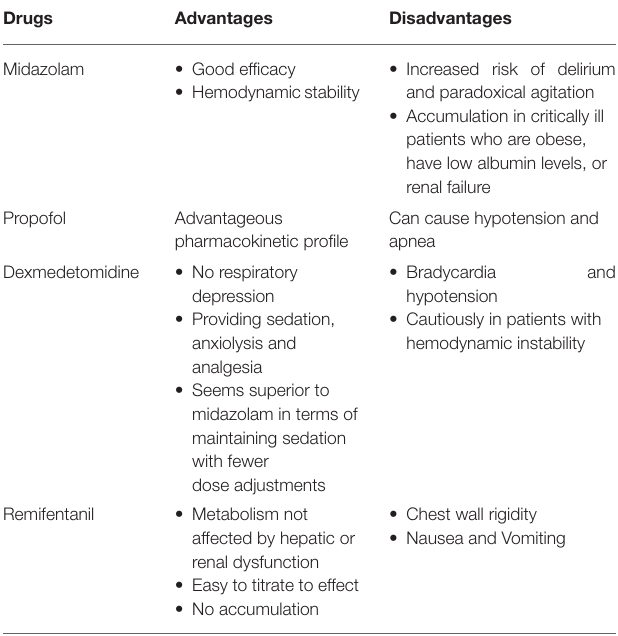
TABLE 3 | Advantages and disadvantages of sedative drugs in NIV * .